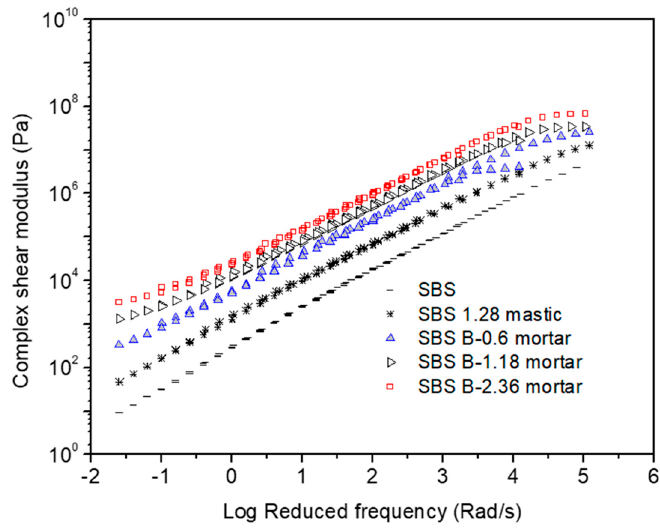
Figure 5. Complex modulus master curves of AC-13 based asphaltic materials including SBS modified asphalt binder, mastic and mortar at a reference temperature of 60 °C .